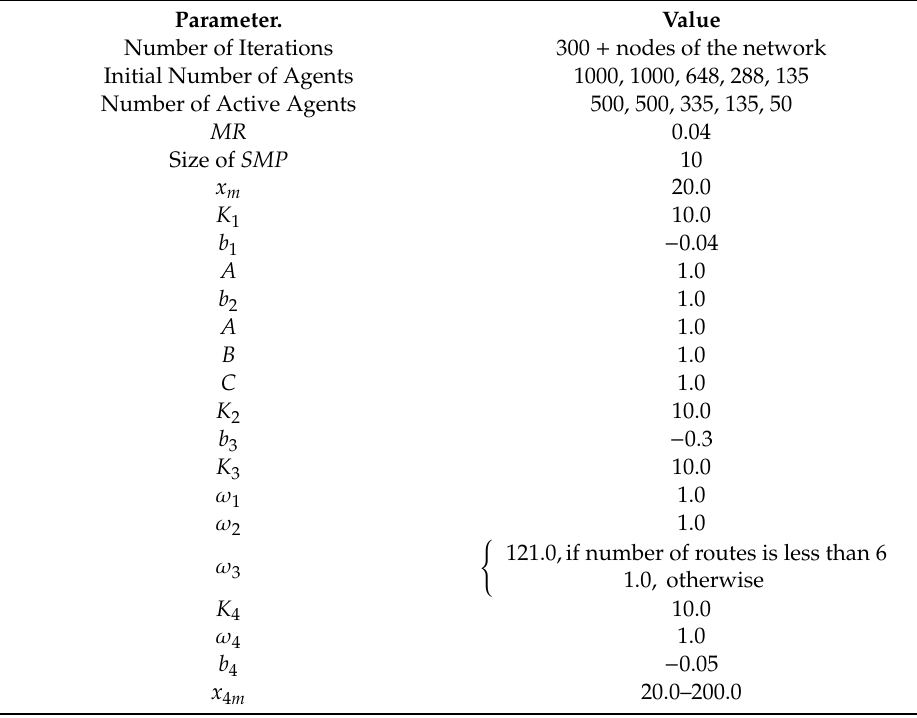
Table 3. Values of the algorithm